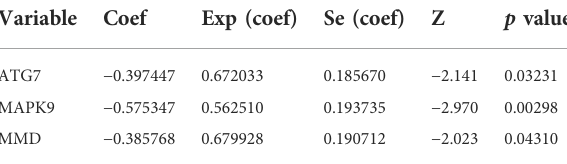
TABLE 4 Multivariate Cox regression analysis of signature in TCGA- COADREAD